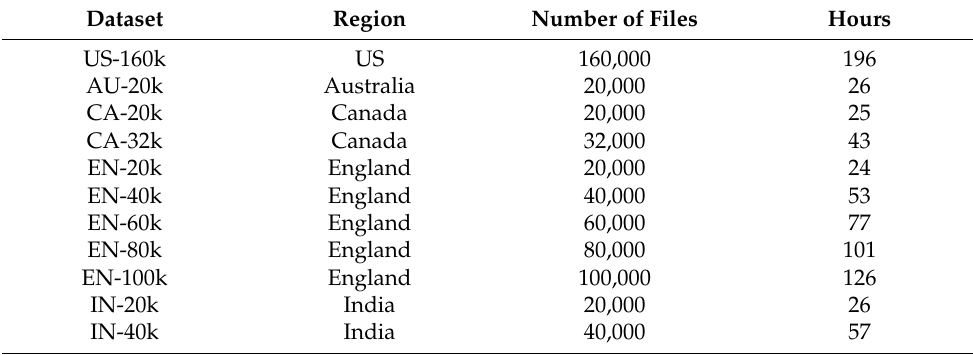
Table 2. Summary of the training set.